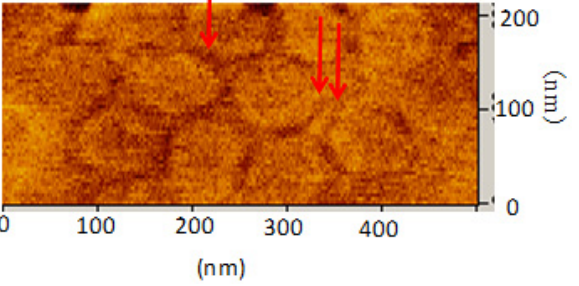
Figure 4. Magnetic force microscope (MFM) images of an H-terminated ferromagnetic GNM on SiC substrate. CoPtCr-coated Si probe was used for the measurements with a tapping mode. The interpore regions, which correspond to GNRs and exhibit darker color, imply high density of polarized spins. They directly suggest that the observed ferromagnetism originates from the GNRs. In particular, two arrows evidently imply the presence of edge polarized